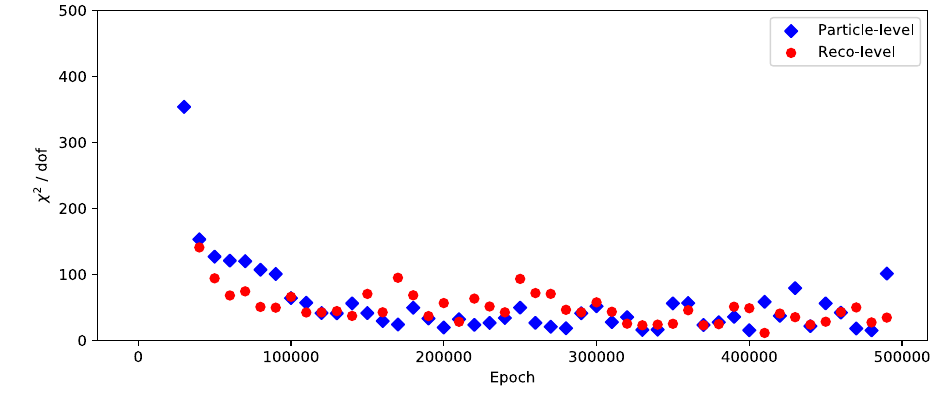
Figure 6 . Evolution of χ 2 as a function of training epoch at particle- and